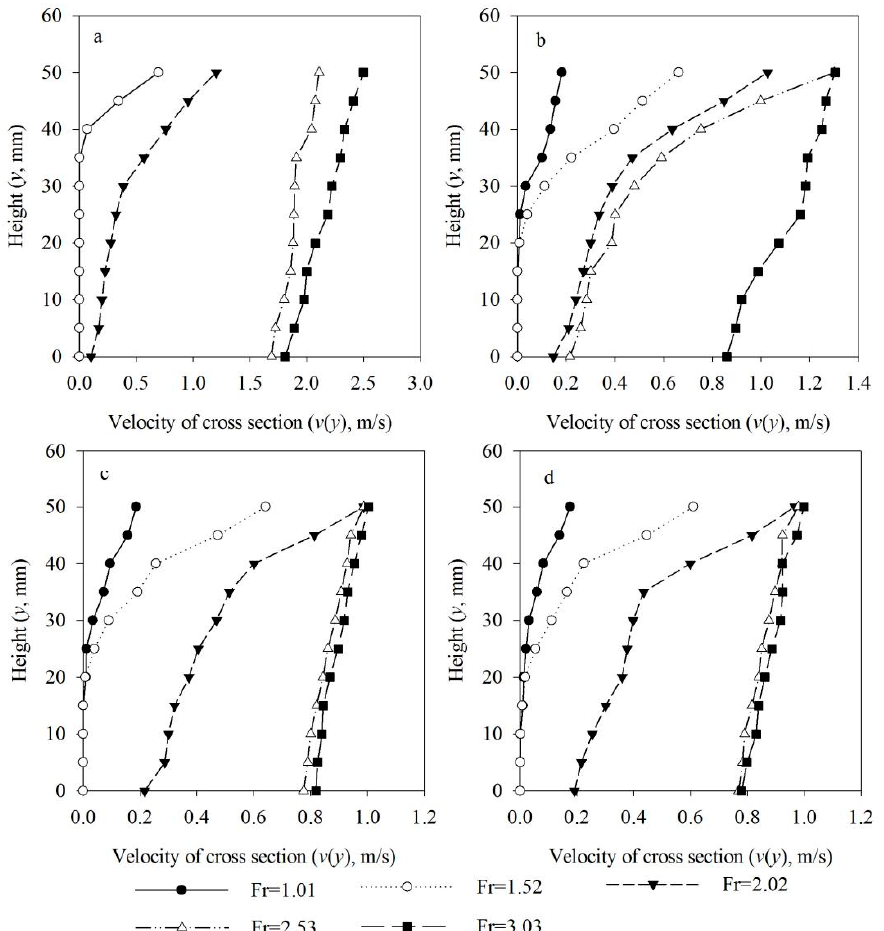
Figure 9. Relationship between vertical velocity distribution of particles and pipeline velocity. Fr, Froude number; d , particle size; D , pipe diameter; ( a ), d / D = 0.02, v s 1.04 ; ( b ), d / D = 0.04, v s 1.04 ; ( c ), d / D = 0.06, v s 1.04 ; ( d ), d / D = 0.1, v s 1.04 .